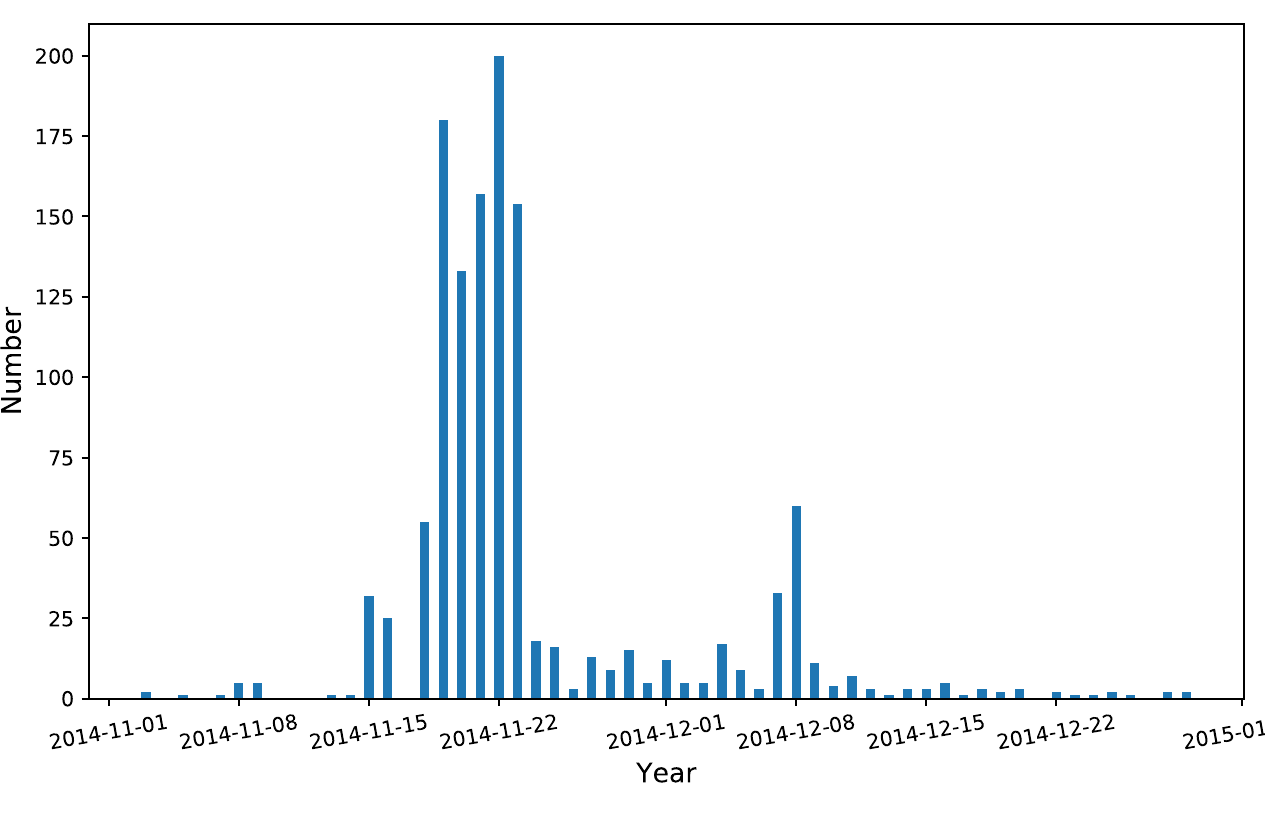
Fig 6. The number of turtles stranded on Cape Cod Bay beaches in Nov-Dec 2014.